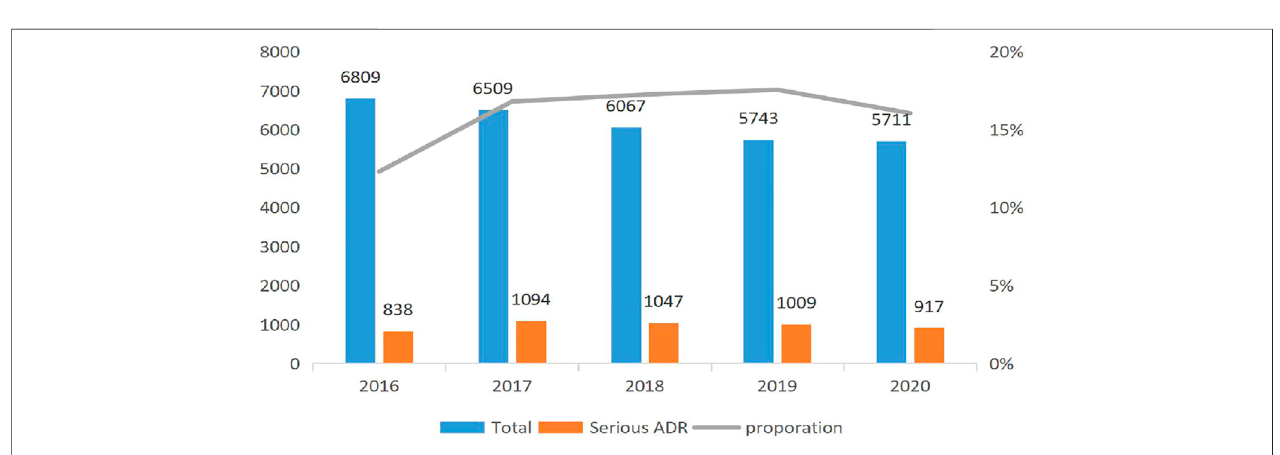
FIGURE 2 | Severity report in each year.